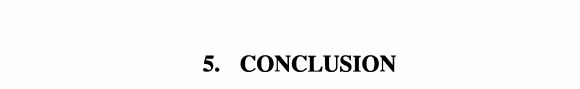
Figure 8. 3D Tiles of buildings, relief, roads, bridges and water